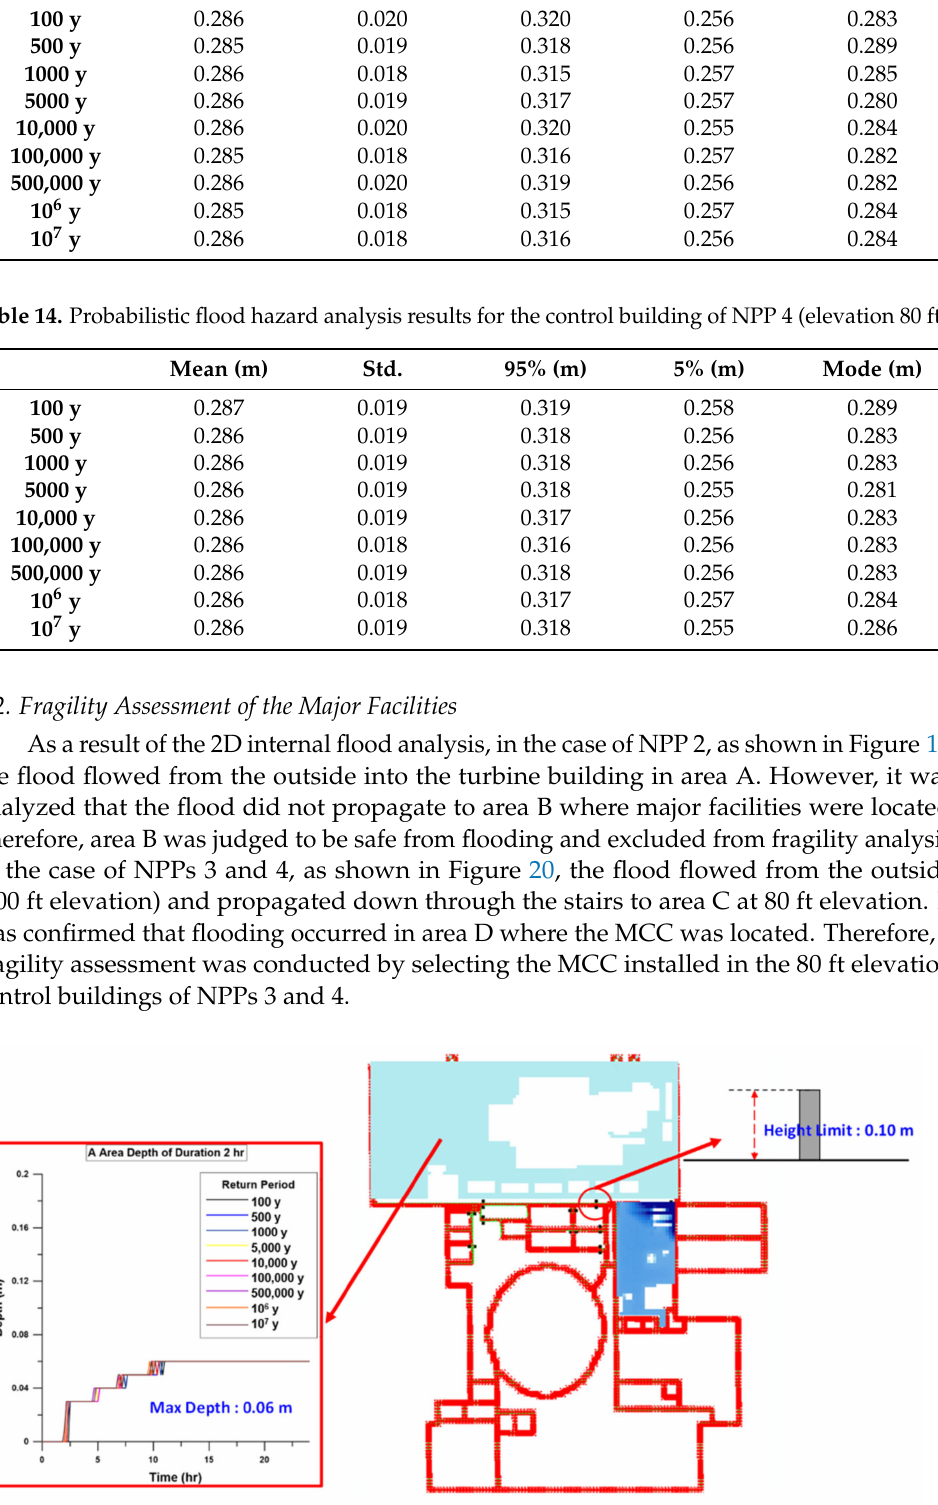
Figure 19. 2D internal flood analysis result for NPP